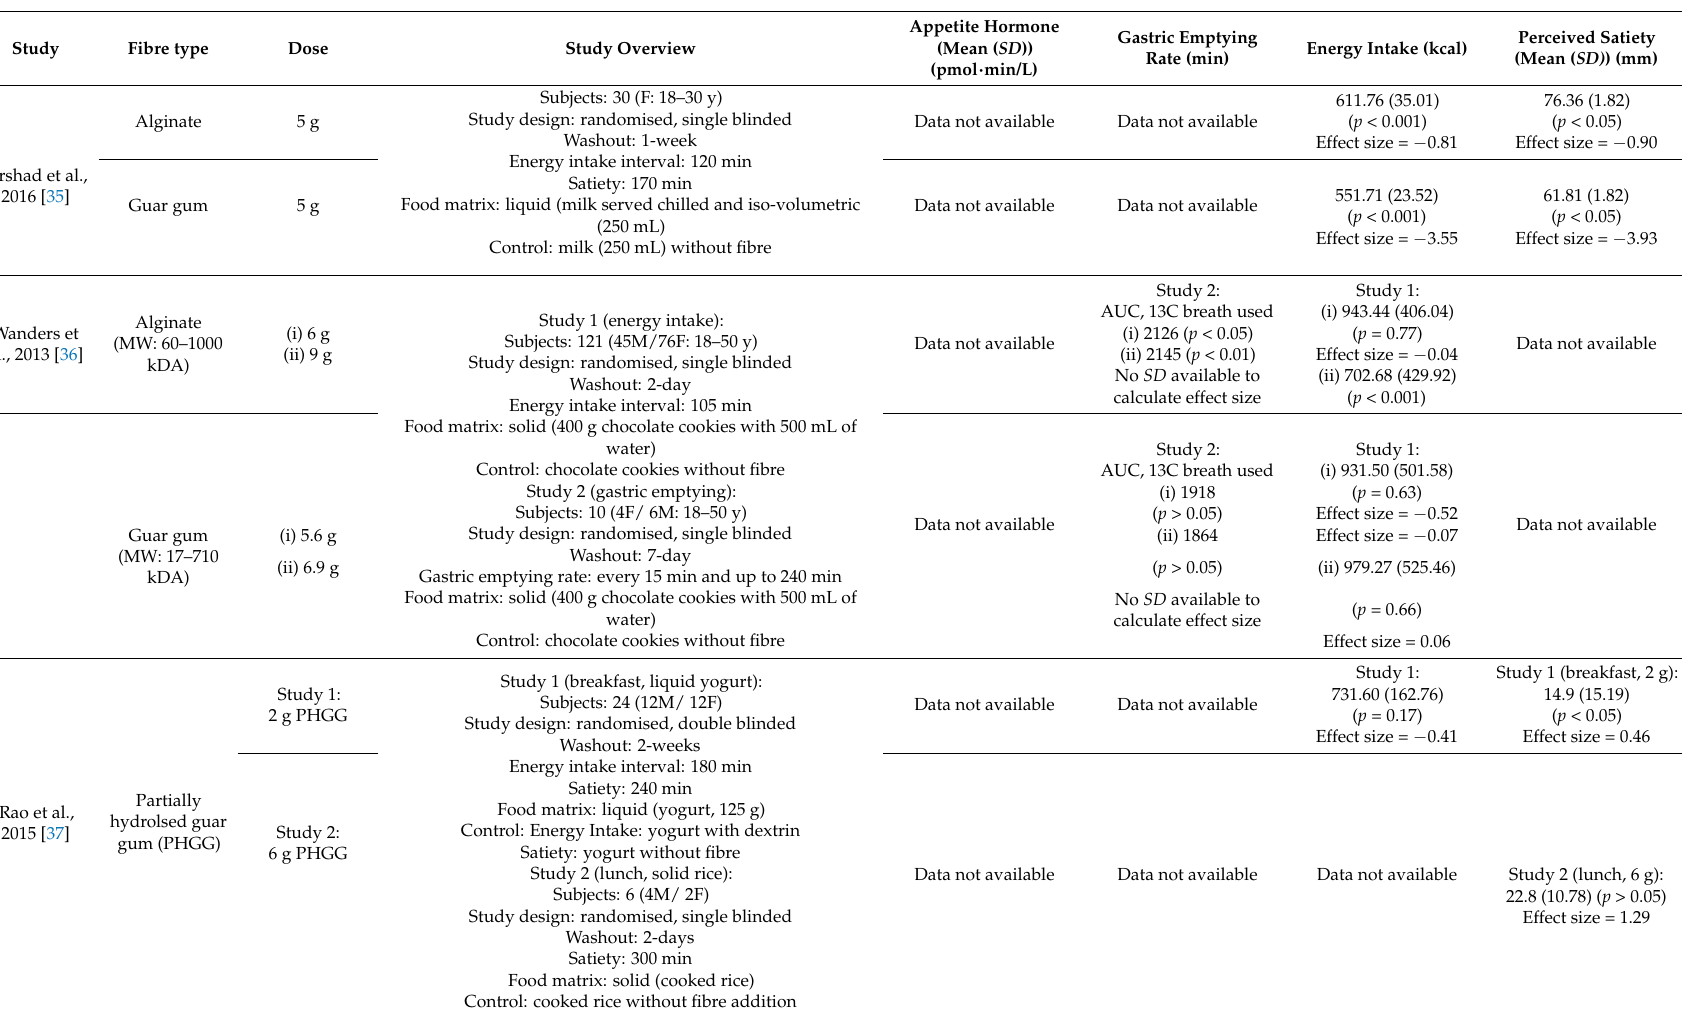
Table 1. Summary of randomized-controlled trials (RCTs) included in systematic review ( n =